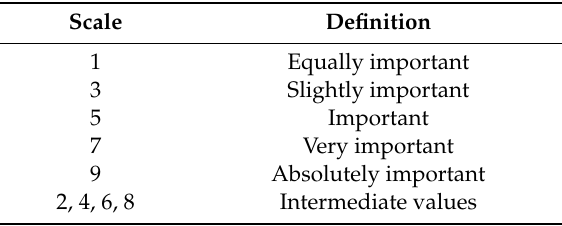
Table 1. Assessment scale and relative definitions of hierarchy